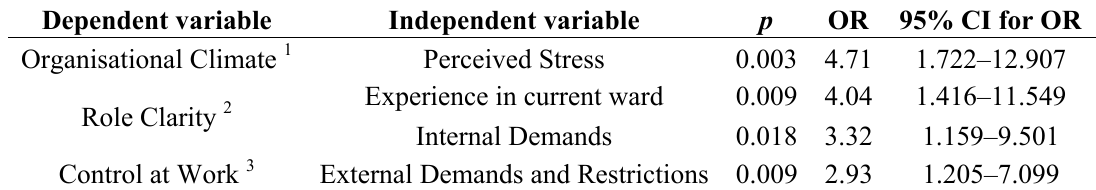
Table 3. Variables of importance to aspects of the psychosocial work